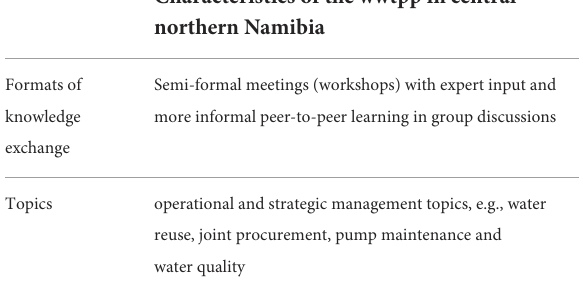
Characteristics of the wwtpp in